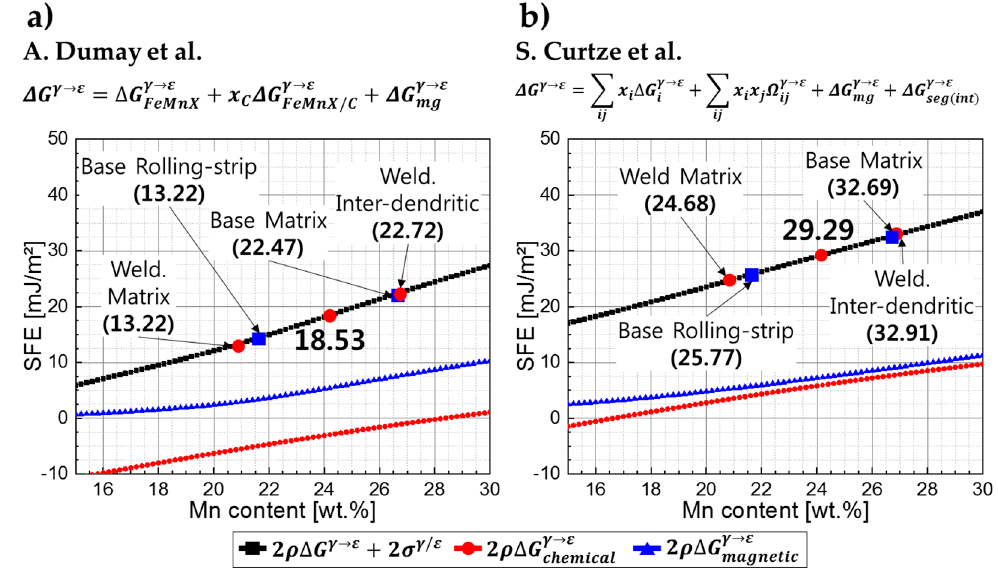
Figure 4. Stacking fault energy calculation depending on alloys content. Equations were presented by ( a ) Dumay et al. [37] and ( b ) Curtze et al. [38].